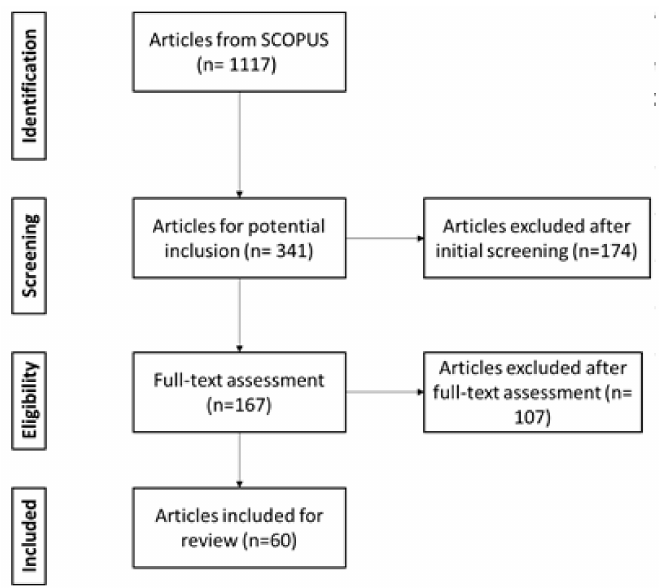
Figure 1. PRISMA